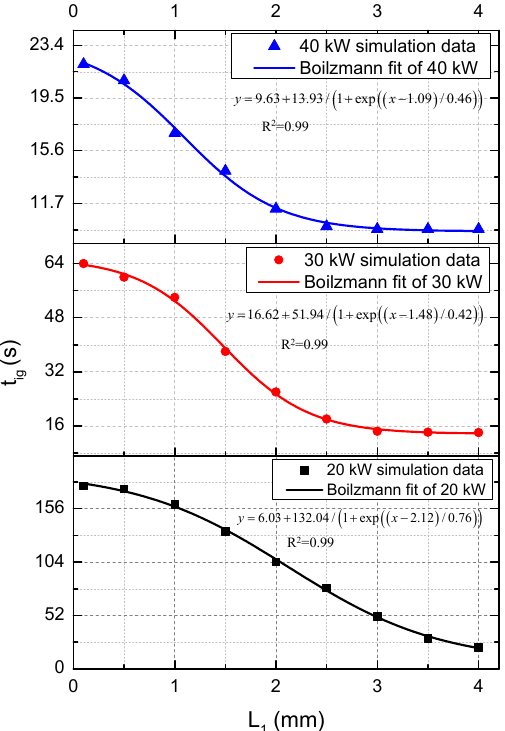
Figure 9. Influence of sheath thickness on ignition time.